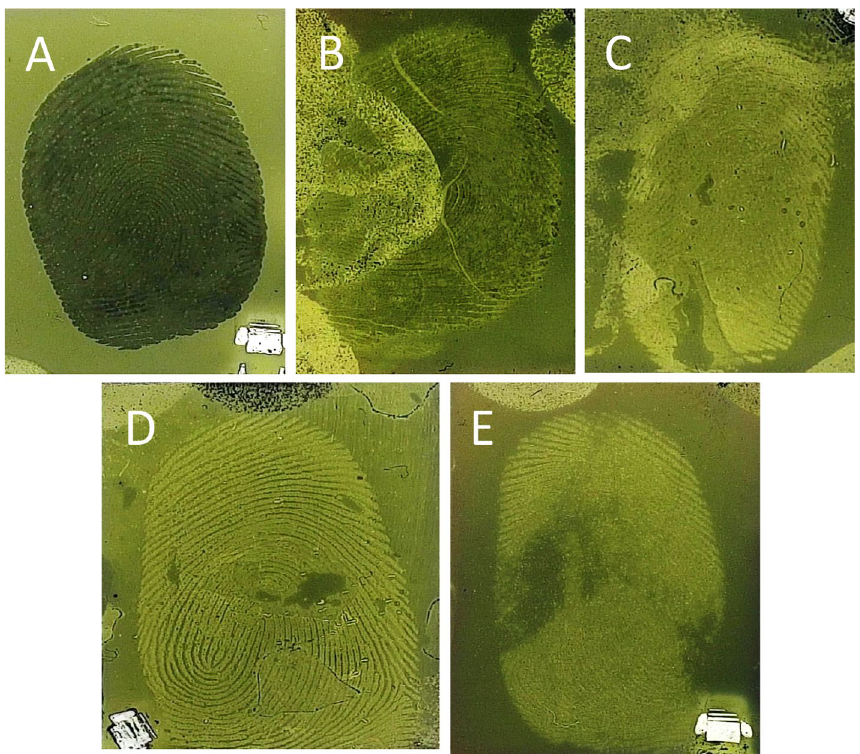
Figure 1. Fingermarks developed on gelatin lifters using the RECOVER system when ( A ) the finger was placed directly onto the gel surface, or fingermarks were lifted from ( B ) copper metal, ( C ) stainless steel, ( D ) glass and ( E )